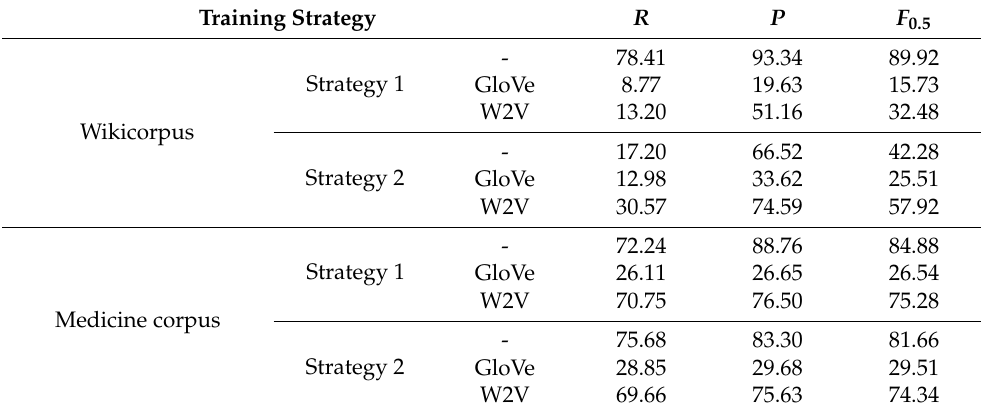
Evaluation of Hunspell-generated error correction . In Table 13, for the medicine corpus the model without pretrained embedding corrected only 36.10% of sentences in the training set generated using strategy 1, whereas the model with